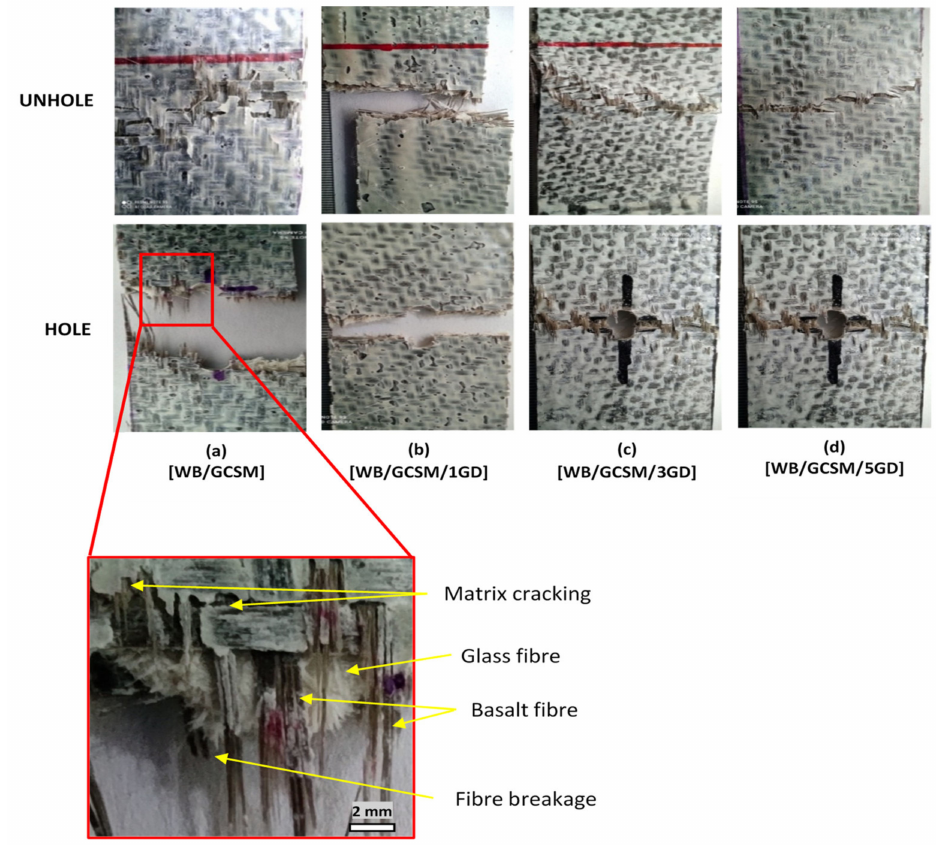
Figure 4. UHT and OHT fracture analysis of [WB/GCSM], [WB/GCSM/1GD], [WB/GCSM/3GD] and [WB/GCSM/5GD] composites after being subjected to tensile